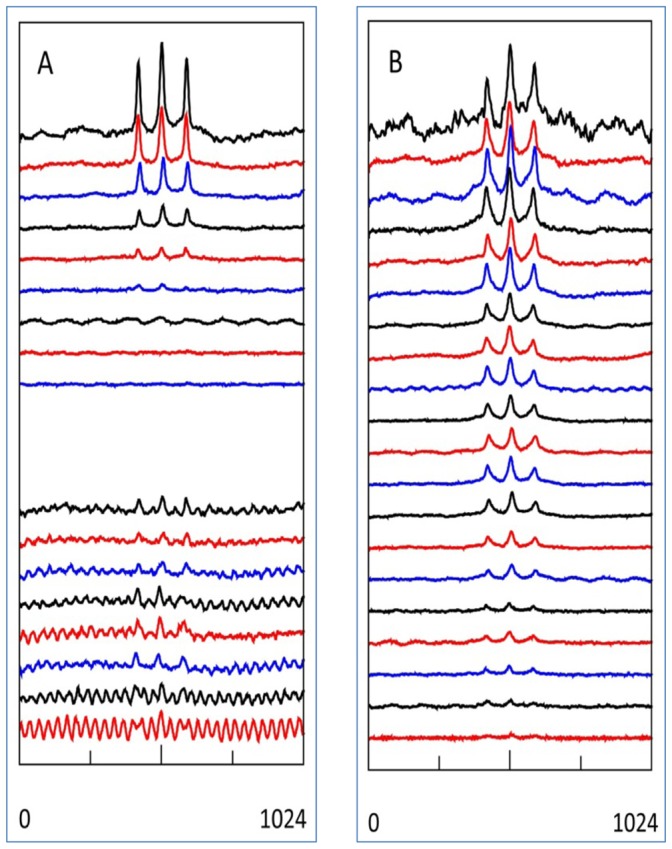
Dependence on frequency and on cell length of aqueous tempo tranmission EPR.Cells (cf Fig. 6) of 1215 cm (A), 300 cm (B) and 75 cm (C) were filled with 1 mM HO-tempo in 100 mM KCl. Spectra were collected at 0.1 GHz intervals from 0.8 GHz (upper trace) till 2.7 GHz (lower trace) as 500 averages of 10+10 s forward-reverse scans (i.e. circa 200 minutes per spectrum) over 200 gauss around the resonance field for g = 2 (i.e. 284±100 gauss for 0.8 GHz to 959±100 gauss for 2.7 GHz). In terms of maximal signal-to-noise the 12 m cell is seen to be optimal for frequencies approximately ≤ 1.1 GHz and the 3 m cell is optimal for circa 1.1–2.1 GHz. The 75 cm cell does not afford sufficient signal under the used conditions.